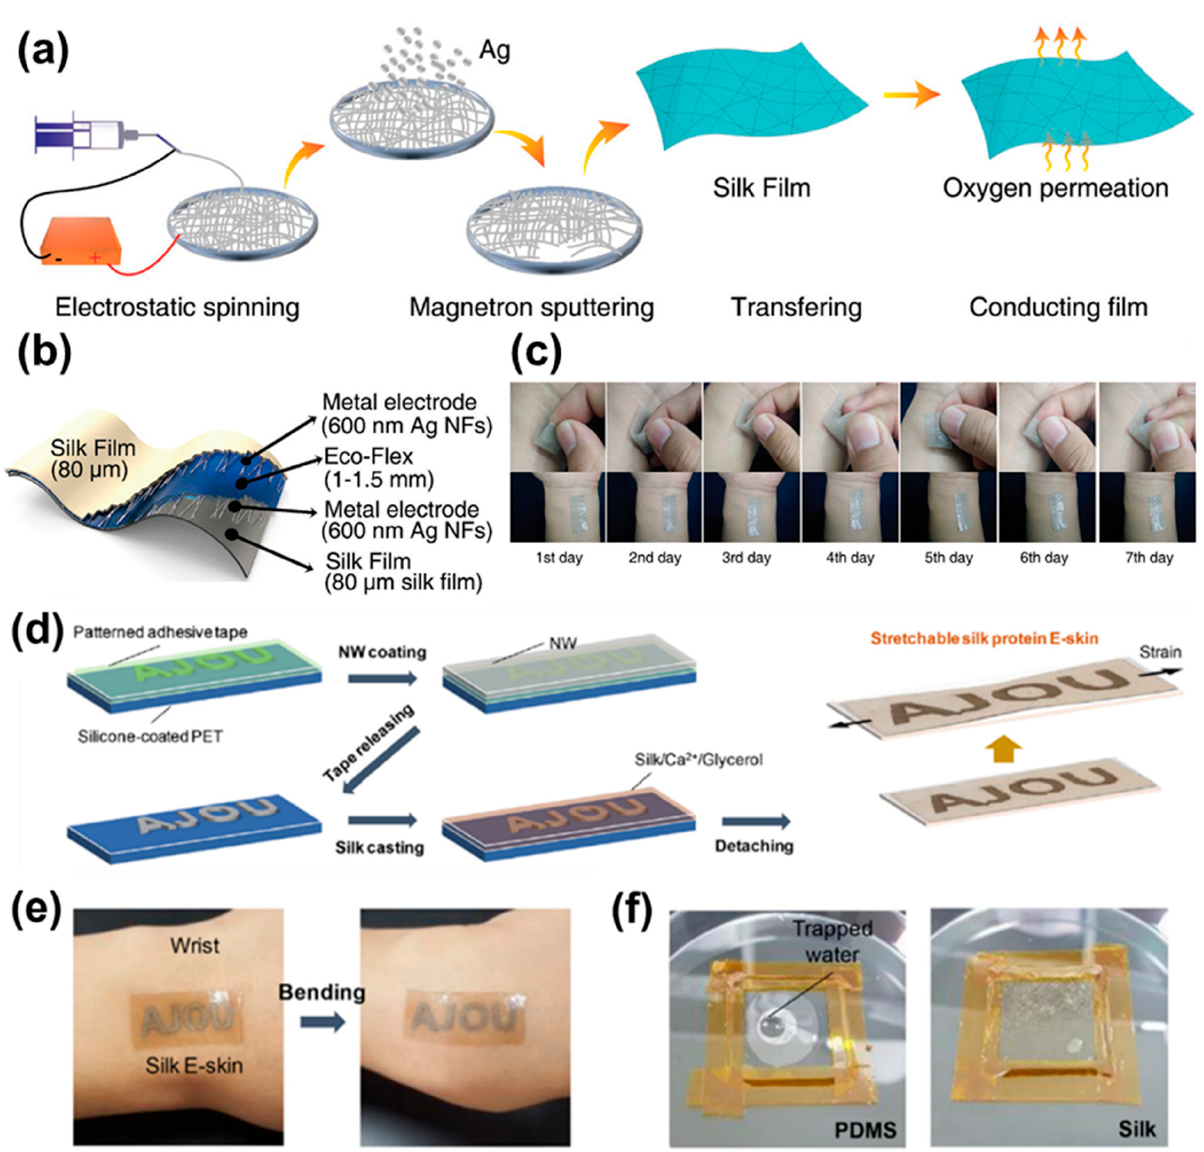
Figure 12. Schematic illustrations. ( a ) Fabrication of AgNF/SF films by electrospinning and magnetron sputtering. ( b ) Structure of the pressure strain sensor. ( c ) Long-term air permeability and biological compatibility tests on human skin [249]. © 2019 Wiley - VCH Verlag GmbH & Co. KGaA, Weinheim. ( d ) Fabrication and working principle of skin-like hydrogel E-skin. ( e ) Silk E-skin adhered to a wrist. No detachment is observed under bending/unbending. ( f ) PDMS and silk membranes [209]. Copyright © 2018, American Chemical Society.